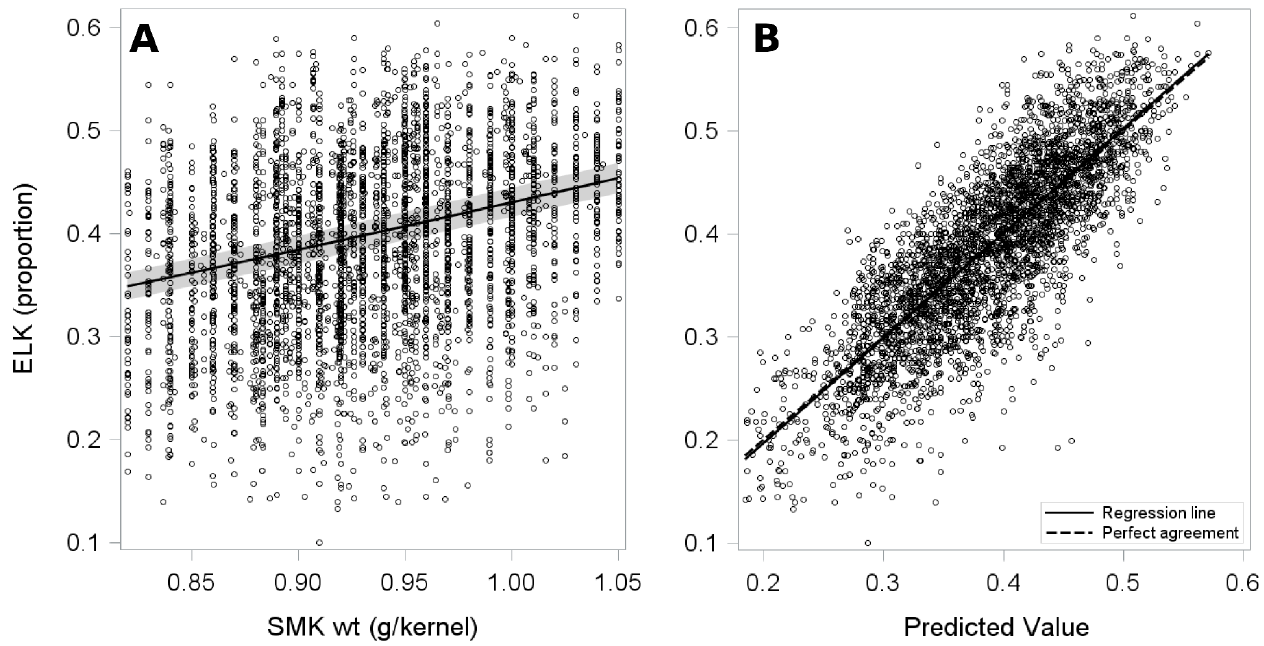
Figure 2. ( A ) Proportion extra large kernels (ELK) predicted by sound mature kernel (SMK) wt (g/kernel) for Virginia market types shelled with a Virginia-type sheller screen on a reciprocating sheller. Corresponding observations versus predicted ELK are shown in panel ( B ) The shaded band corresponds to the 95% confidence interval. Predictions were estimated according to the following function with a beta distribution for the response: ELK ij = b × SMKwt i + I + S j + e ij . S j and e ij were the random effect of study and the residual, respectively. The estimated slope ( b ) and intercept ( I ) model-scale parameters, slope and intercept parameter p values, study variance ( S j ), and concordance correlation coefficient were 1.909, −2.190, <0.001, <0.001, 0.105, and 0.804.